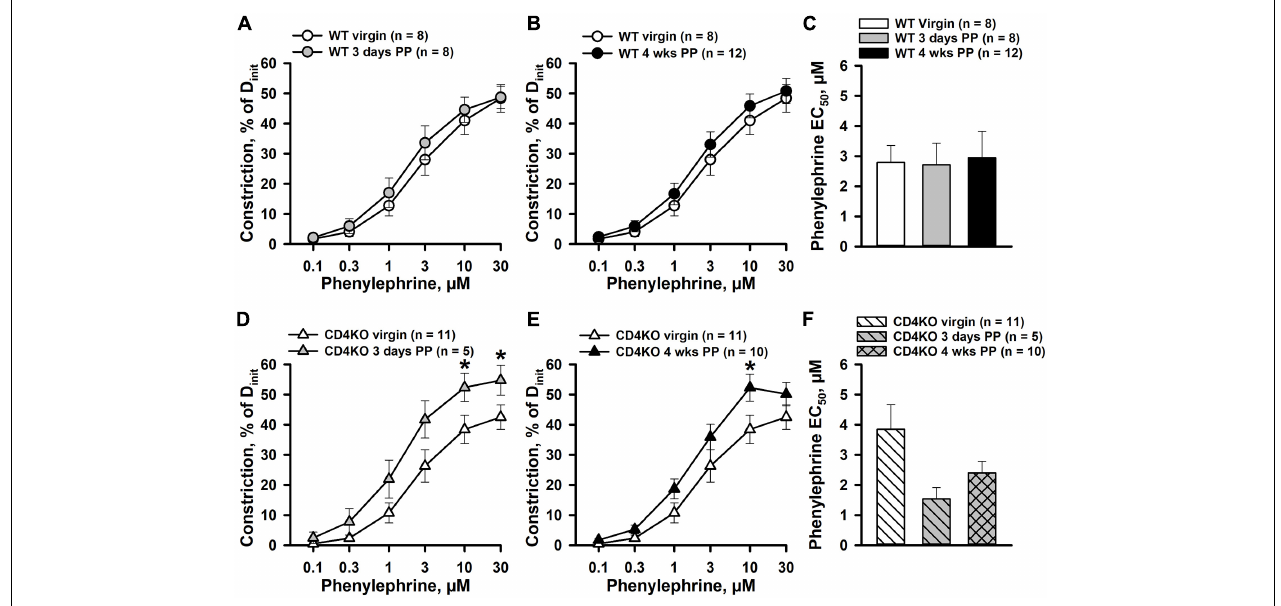
FIGURE 1 | Differential effects of pregnancy on phenylephrine (PE)-induced constriction of internal carotid arteries (ICAs) from C57BL/6 wild-type (WT) and CD4 T cell deficient (CD4KO) mice. (A,B) PE induced a comparable concentration-dependent constriction of arteries from WT virgin, 3 days and 4 weeks postpartum (PP) WT mice ( P > 0.05, two-way ANOVA). (C) A bar graph showing no difference in concentration of PE producing 50% constriction (EC 50 values) of ICAs from virgin vs. PP mice ( P > 0.05, one way ANOVA). (D,E) Enhancement of PE-induced constriction of ICAs from CD4KO 3 days and 4 weeks PP mice (* P < 0.05, two way ANOVA). (F) A bar graph demonstrating a trend in reduction of EC 50 values for PE-induced constriction of ICAs from CD4KO - PP mice compared to virgins ( P > 0.05, one way ANOVA).